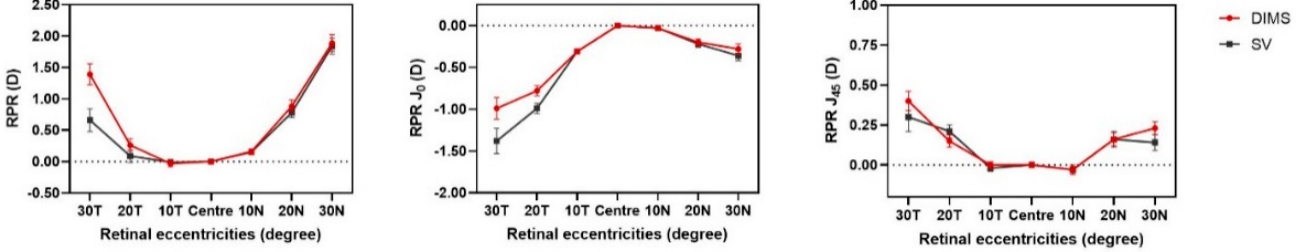
Figure 1. The profile of RPR (SE, J 0 , J 45 ) across the horizontal retina of children in DIMS group (n = 79) and SV group (n = 81) at baseline. No statistically significant difference in baseline RPR (SE, J 0 , J 45 ) between two groups after Bonferroni correction ( p > 0.008). Error bars denote SEM. Zero horizontal lines have been shown as dashed lines.